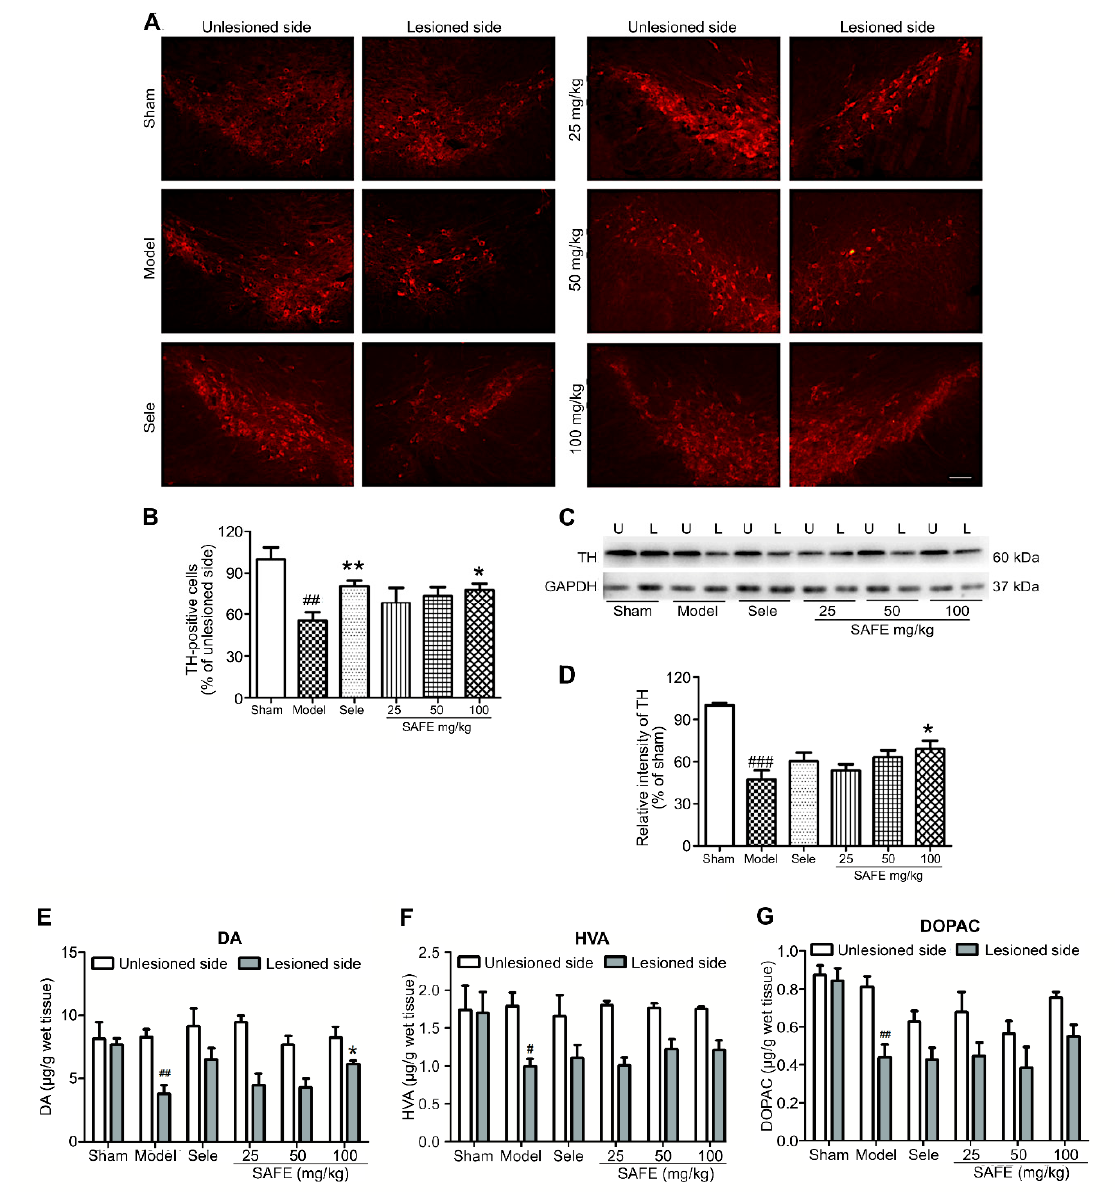
Figure 2. Effect of SAFE on dopamine metabolism. ( A ) Representative photographs of tyrosine hydroxylase (TH)-stained sections (bar = 100 µ m) in the substantia nigra (SN); ( B ) Ratios of TH-positive cells numbers in the lesioned SN to those in the unlesioned SN of each group, n = 5; ( C ) Representative Western blot for TH protein in the SN. U, unlesioned side and L, lesioned side; ( D ) Quantitative analysis of the relative intensity of TH / GAPDH in lesioned side of each group as compared with that of the sham group, n = 3; Contents of dopamine (DA) ( E ), homovanillic acid (HVA) ( F ), and dihydroxyphenyl acetic acid (DOPAC) ( G ), respectively, in the striatum measured by high-performance liquid chromatography coupled with electrochemical detection (HPLC-ECD), n = 4. # p < 0.05, ## p < 0.01, ### p < 0.001 vs. sham group and * p < 0.05, ** p < 0.01 vs. model group.